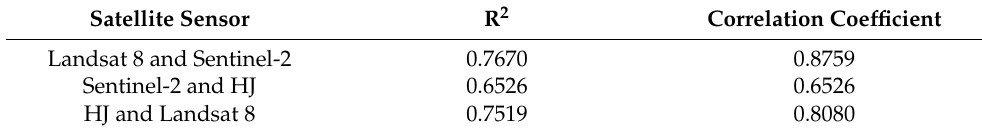
Table 6. The NDVI fitting results of the Inner Dump under multi-source sensor monitoring. Satellite